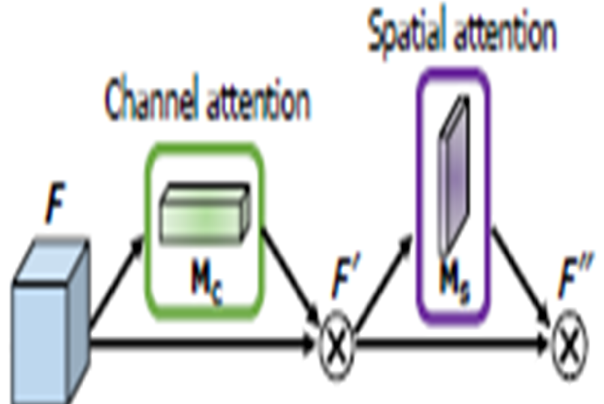
Figure 5. Illustration of a convolutional block attention module (CBAM).